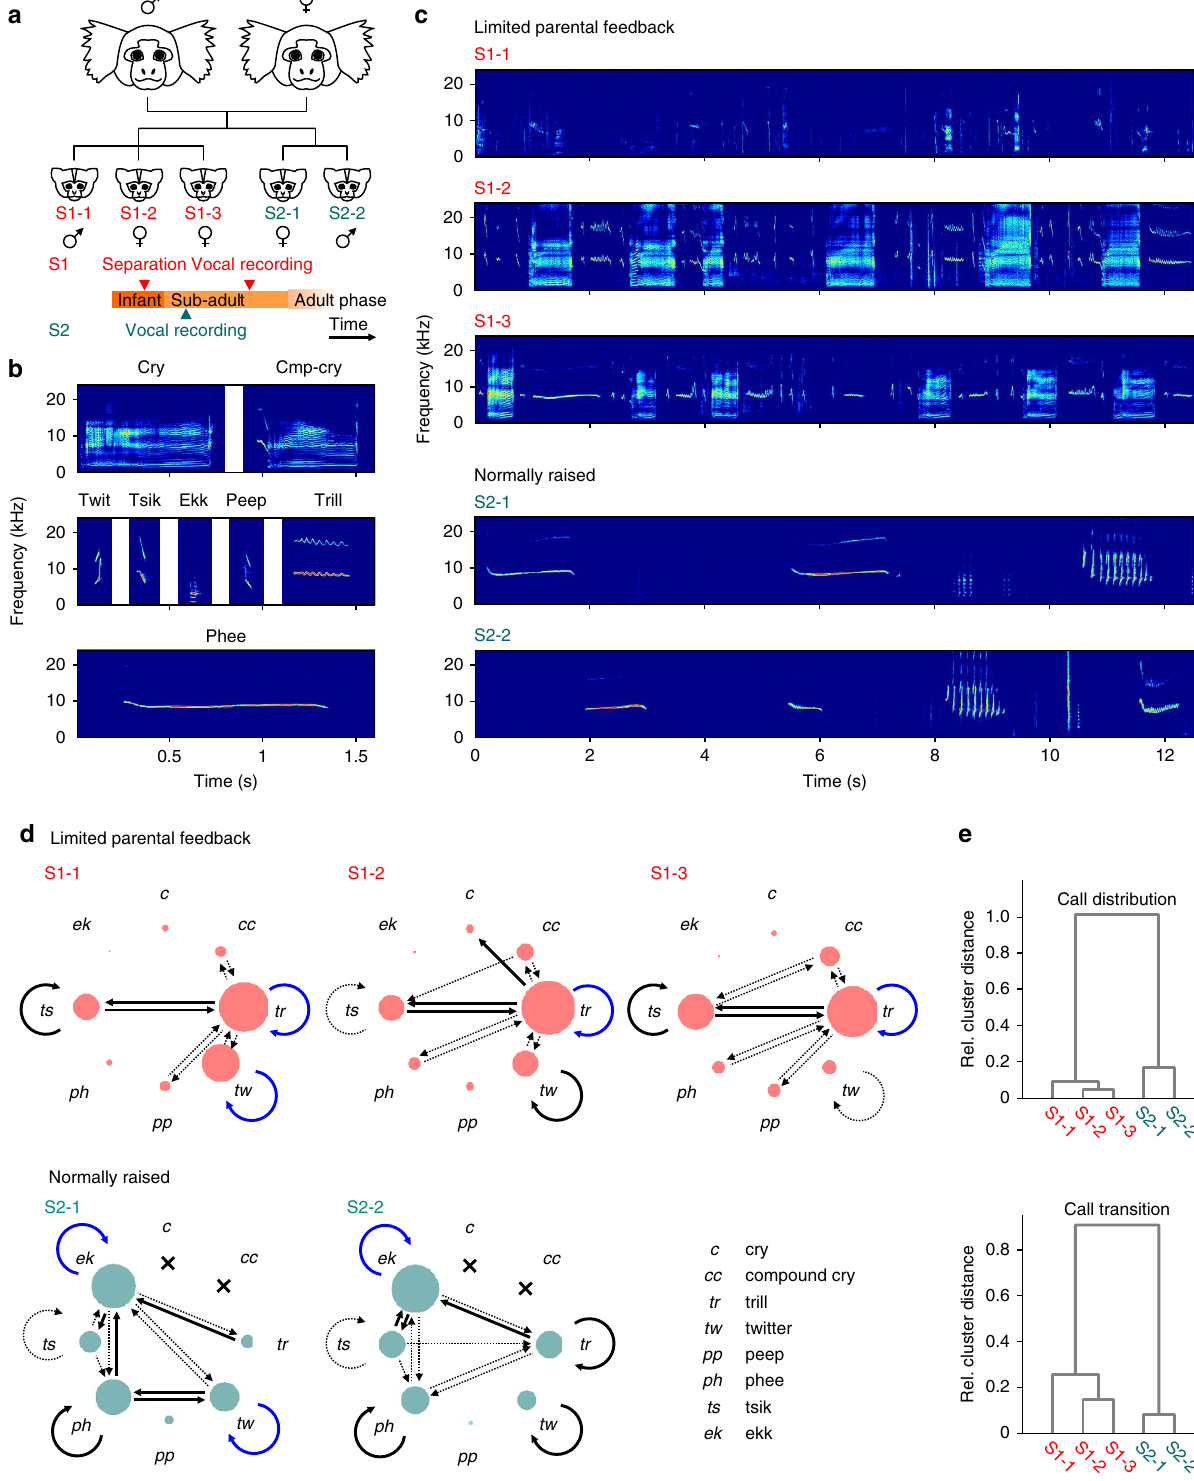
Figure 1 | Vocal development of subadult marmoset monkeys depends on parental feedback. ( a ) Top: family relationship of the five siblings. The triplets with limited parental feedback (S1-1, S1-2 and S1-3) were born prior to the normally raised twins (S2-1, S2-2). Bottom: experimental timeline indicating separation of the S1 siblings and vocal recordings in the S1 and S2 group, respectively. ( b ) Examples of uttered call types. ( c ) Spectrograms of vocal sequences produced by the five marmoset monkeys indicate differences in vocal behaviour between S1 and S2 offspring. ( d ) Transition diagrams visualizing vocal sequences of S1 and S2 monkeys. Each node in the diagram corresponds to a type of call, and the arrows correspond to the transitions between call types. Node size is proportional to the fraction of the call types, and edge size is proportional to the transition probability between calls. Blue arrows are transitions above 10% occurrences, black solid arrows between 5% and 10% and dashed arrows between 1% and 5%. ( n ¼ 13,582 vocalizations) ( e ) Clustering dendrogram of the five monkeys based on call distribution and transition (weighted linkage method with Spearman’s proximity